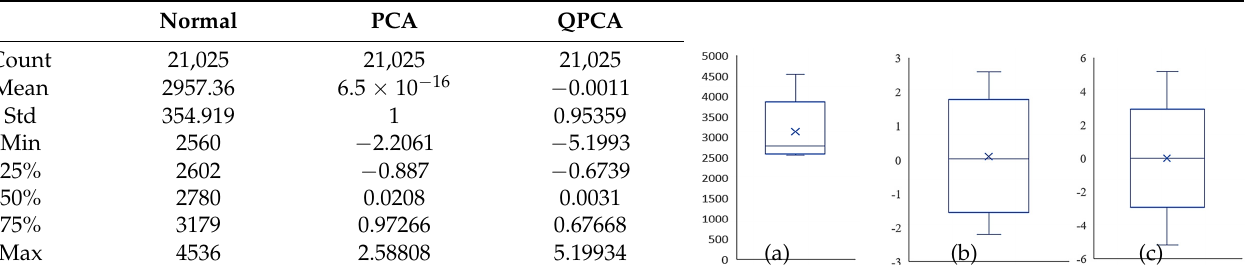
Table 2. One example for the data distribution of the Indian Pines (IPs) dataset (band-1). (a) is the distribution of the original data, (b) is for the data after using PCA, and (c) is the shape of the data after using QPCA.